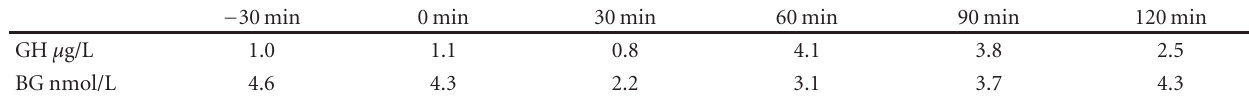
BG: blood glucose. Normal references for basal GH appear in Table 2.